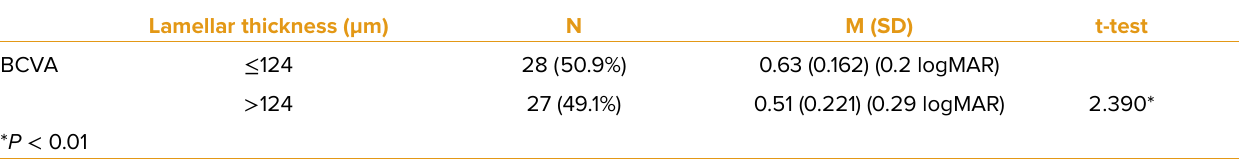
Table 3. T -test for differentiated lamellar thickness between preoperative and postoperative determined according to the lamellar